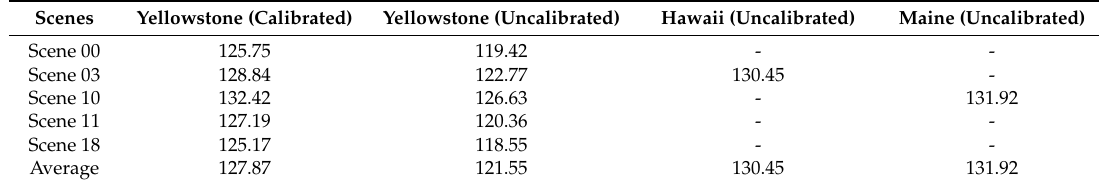
Table 5. Achieved results in terms of PSNR, by embedding w 1 (Dataset 2).